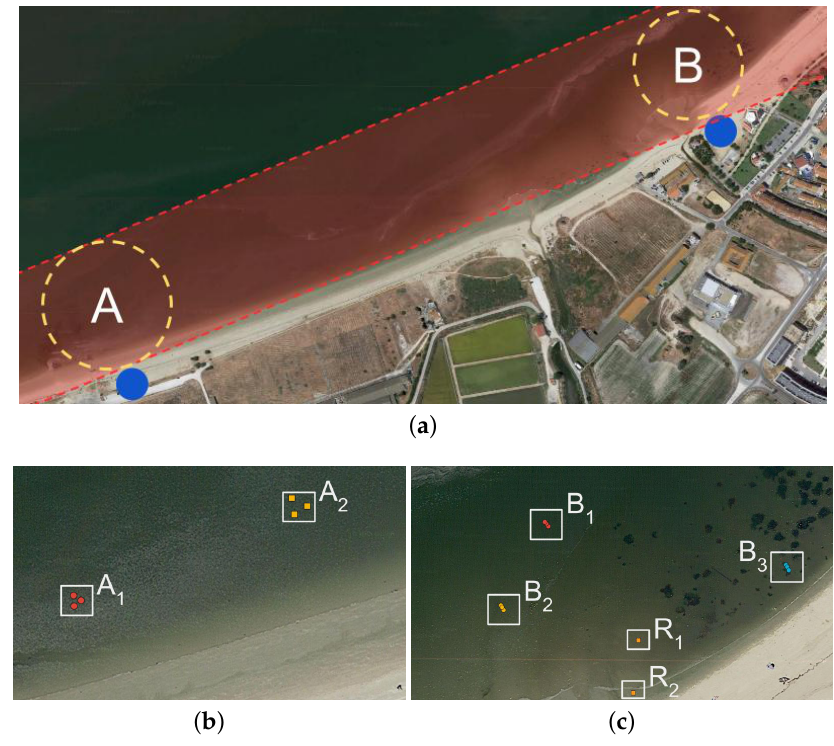
Figure 17. The field trials sites. ( a ) Satellite image covering the field trials sites. The circles represent the two sampling sites, A and B , visited during the field trials along the longitudinal transect. The filled circles represent the locations of the base station in both sampling sites. ( b ) A close-up perspective over site A ; ( c ) a close-up perspective over site B . The several labels in (b,c) represent sampling locations. The depicted satellite images were acquired during a high tide, which explains why the overlaid sampling sites appear on water regions. Courtesy of Mapdata c (cid:13) 2016